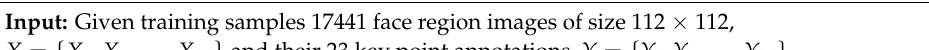
Algorithm 1: Training strategy of